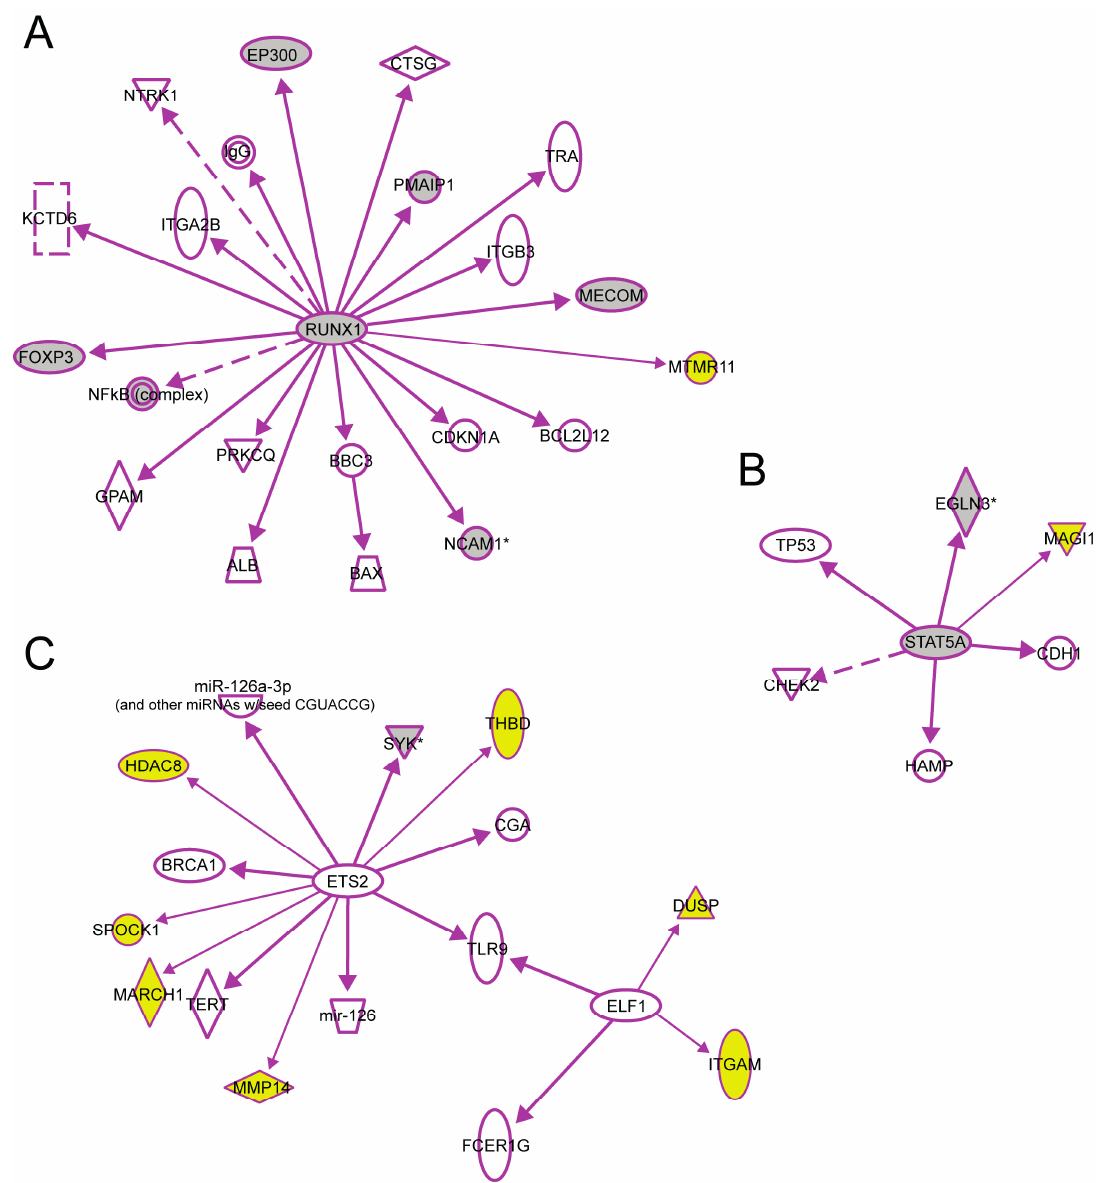
Figure 7. Experimentally validated direct interactions of transcription factors ( A ) RUNX1, ( B ) STAT5 and ( C ) ELF1, ETS2 with their target genes. Qiagen’s Ingenuity Pathway Analysis ® tool was used to demonstrate the downstream interactions of TFs to genes with experimental evidence that their transcription is regulated directly by one of the TFs studied here. In addition, the genes MTMR11 , DUSP10 , ITGAM , MARCH1 , HDAC8 , MMP14 , MAGI1 , THBD and SPOCK1 identified as target genes for these TFs in human aorta in the current study using ChIP-chip and q-PCR were also included (yellow symbols). Eight of the previously known target genes (gray symbols) were also identified in the current ChIP-chip dataset. Two of the target genes shown in this figure ( SYK and PMAIP1 ) had significantly different mRNA levels between AAA and control aorta